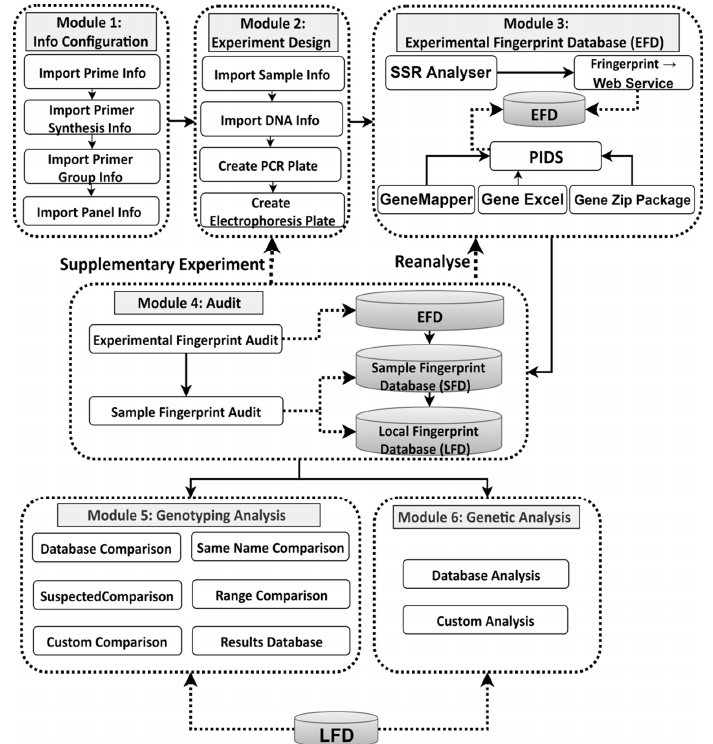
Figure 2. Modular structure of plant international DNA-fingerprinting system (PIDS), including the workflows between the modules and functions. PIDS covers three core fingerprint databases and the data transfer relationship between them. Modules 5 and 6 perform the core functions of identification and data analysis. The workflows ensure that the entire experiment and data analysis is a closed loop process. When problems occur, they can be solved by supplementary experiments or reanalysis, which can improve the e ffi ciency of the data transfer